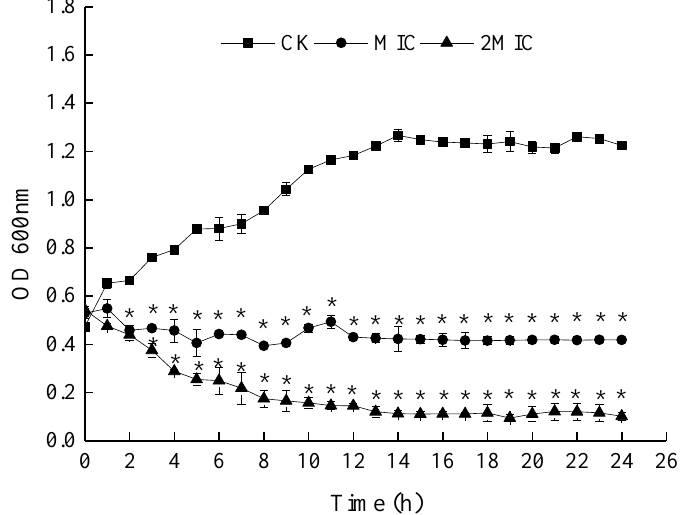
Figure 2. E ff ect of ε -PL on the growth curve of S. putrefaciens. Bars represent the standard error of the means. The superscript (*) indicates a result that is significantly di ff erent to the equivalent control point ( t test, p <